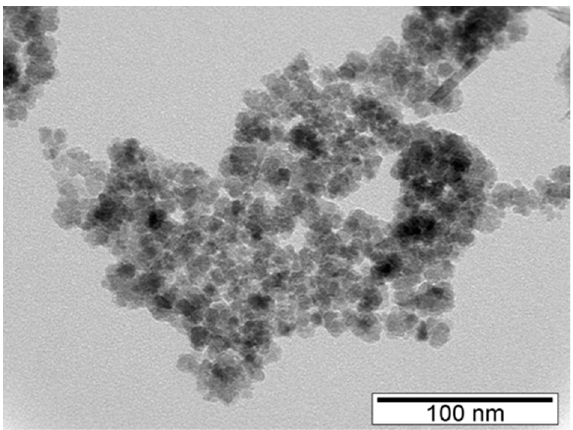
Figure 1. TEM micrograph of naked SPIONs: A 1.1.